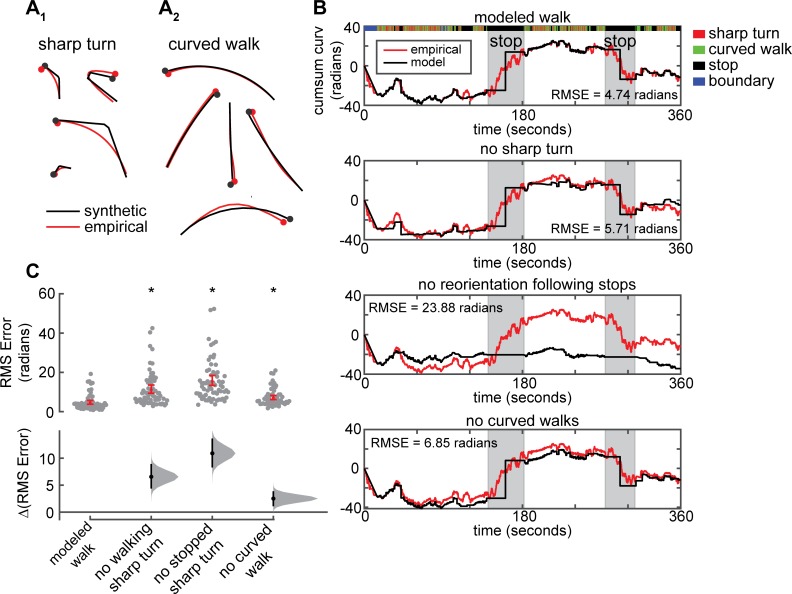
Three ways to change orientation: curved walk, sharp turn and stop.A. Synthetic tracks generated using mean speed and curvature closely approximate empirical tracks. Examples of sharp turn (left) and curved walk (right) are shown. Filled circle marks the end of the track. B. Cumulative curvature of the empirical track is compared to the modeled track, and to the modeled track without one of the three states. C. The distribution of mean RMSE of the cumulative sum of the curvature for each model for all flies (n = 66). Taking out any of the three forms of reorientation significantly deteriorates the ability of the model to approximate empirical change in curvature (*, p < 0.01).